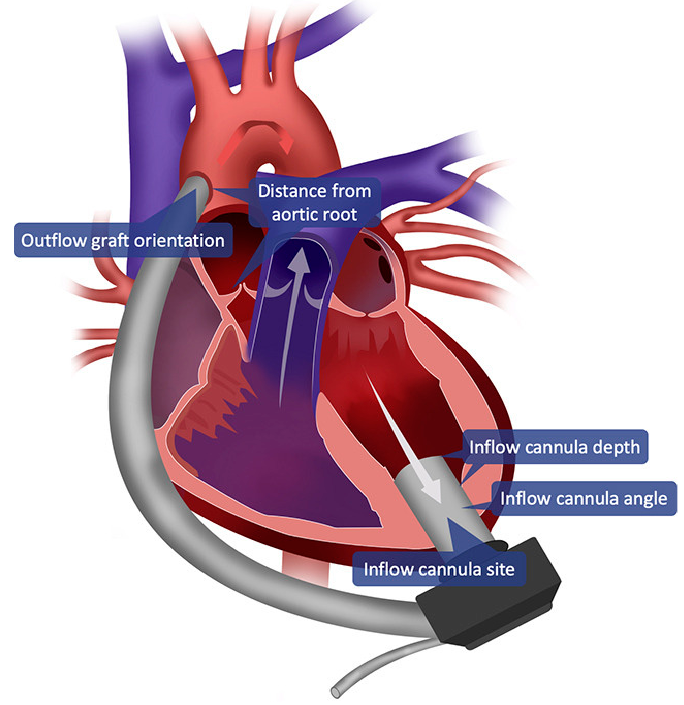
Figure 1. Left ventricular assist device configuration.